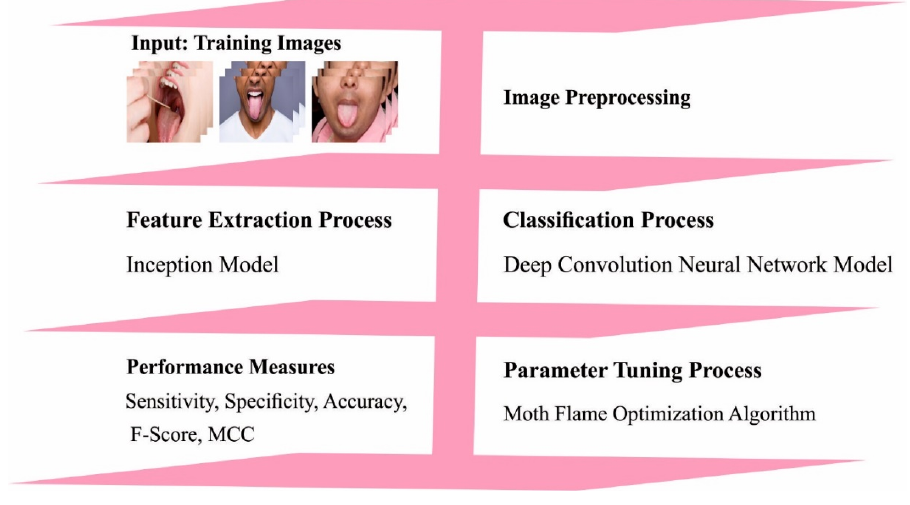
Figure 1. Working outline of OIDCNN-OPMDD approach.